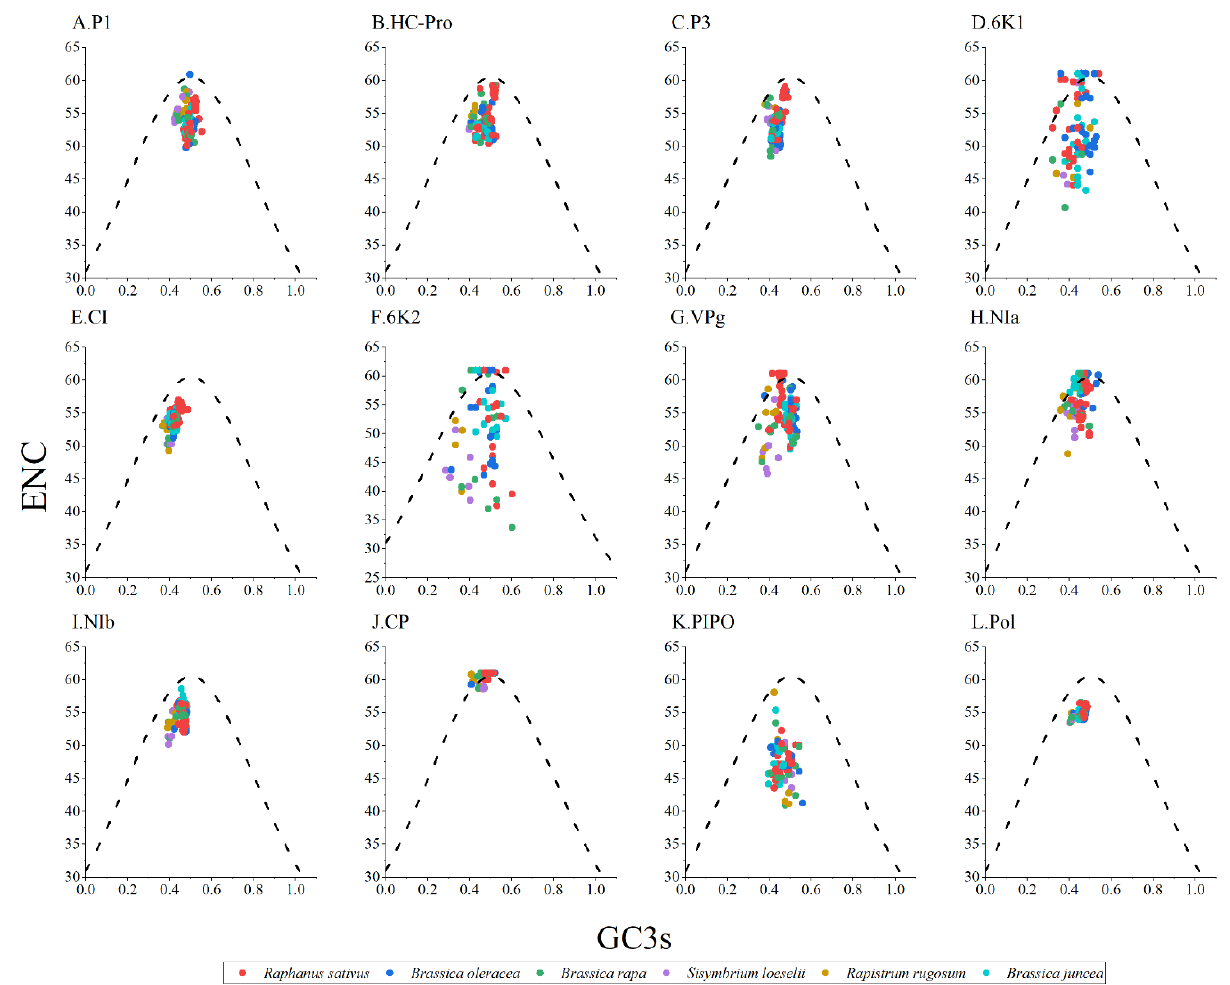
Figure 3. Effective number of codons analysis (ENC)-plot analysis of the individual protein ( A – K ) and complete polyprotein ( L ) coding sequences of turnip mosaic virus, with ENC against the GC3s of different hosts. The black dotted line represents the standard curve when the codon usage bias is determined by only the GC3s composition. The Raphanus sativus , Brassica oleracea , Brassica rapa , Sisymbrium loeseli , Rapistrum rugosum and Brassica juncea hosts are represented in red, blue, green, purple, orange, wathet blue and brown, respectively.